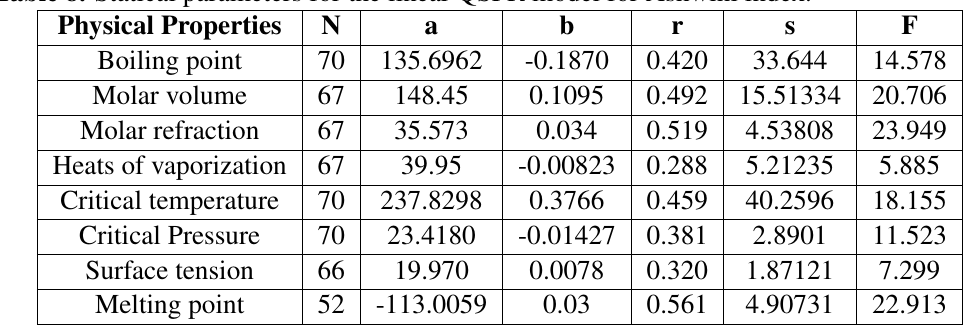
Table 8. Statical parameters for the linear QSPR model for Ashwini index.